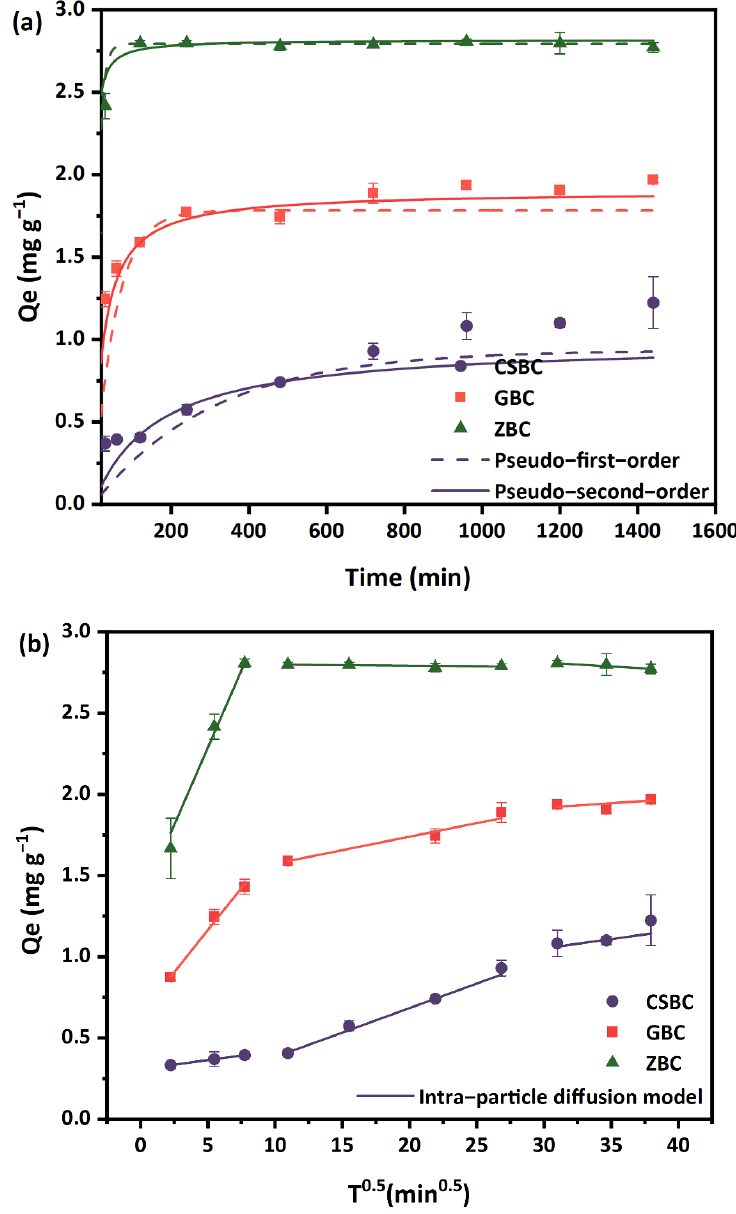
Figure 4. Adsorption kinetics of P by CSBC, GBC, and ZBC: ( a ) pseudo − first − order and pseudo − second − order models; ( b ) intra − particle diffusion model. (Adsorbent dose: 5 g L − 1 ; P initial concentra- tion: 15 mg L − 1 ; pH: 6; temperature: 25 °C; ionic strength: 0.01 M.)